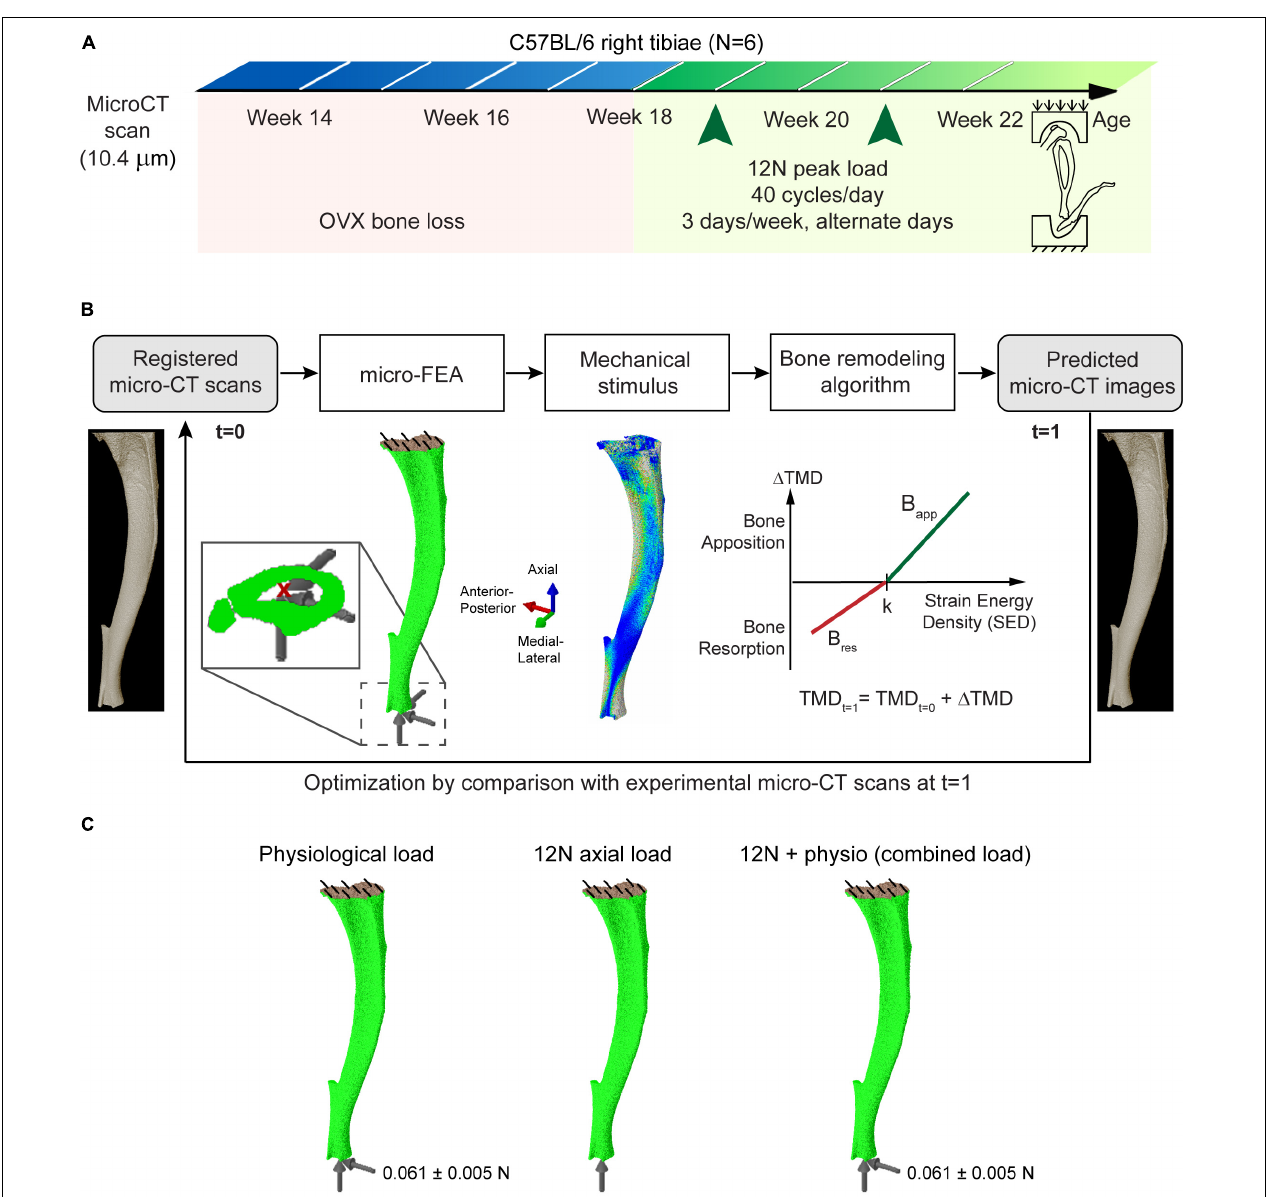
FIGURE 1 | (A) Schematic of the in vivo loading experiment. (B) Overview of the workflow used in determining the parameters of bone adaptation and the computational algorithm used. (C) The evaluated loading and boundary conditions.